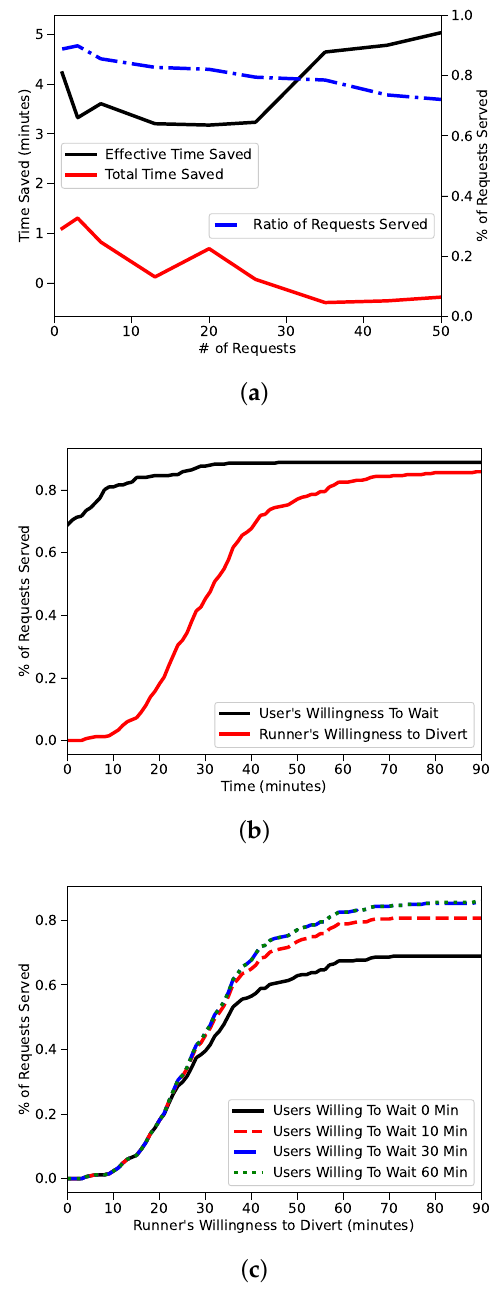
Figure 3. ( a ) presents the loss of as number of requests increase in the UCI campus. ( b , c ) highlight impact users and drivers willingness to wait drivers willingness to divert [21] ©2020